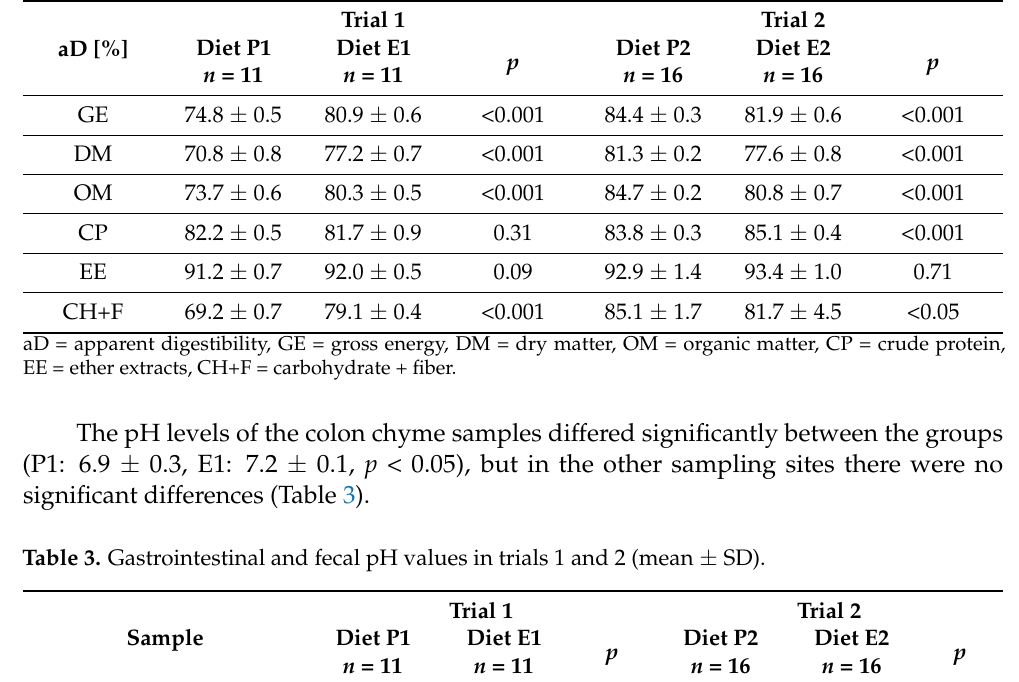
Figure 1. Body weight development of the mice in trial 1. Mice fed diet E1 show higher gains. Mice maintained on diet E1 showed significantly higher apparent digestibility coeffi- cients of GE, OM, and the CH+F (carbohydrate + fiber) fraction than group P1 ( p < 0.001; Table 2). There were no significant differences in the digestibility of CP and EE between P1 and E1 ( p = 0.31 and 0.09, respectively). Table 2. Apparent digestibility of gross energy and nutrients (mean ± SD (%)) in the pelleted (P) and extruded (E) diets from trials 1 and 2.